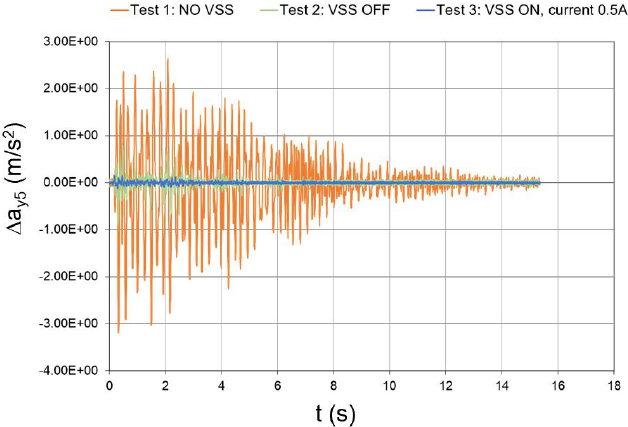
Figure 53. Seismic response (experimental data), interstory acceleration at the 5th floor ( Δ 𝑎 y5 = 𝑎 y5 𝑎 y2 − 𝑎 y4 ).